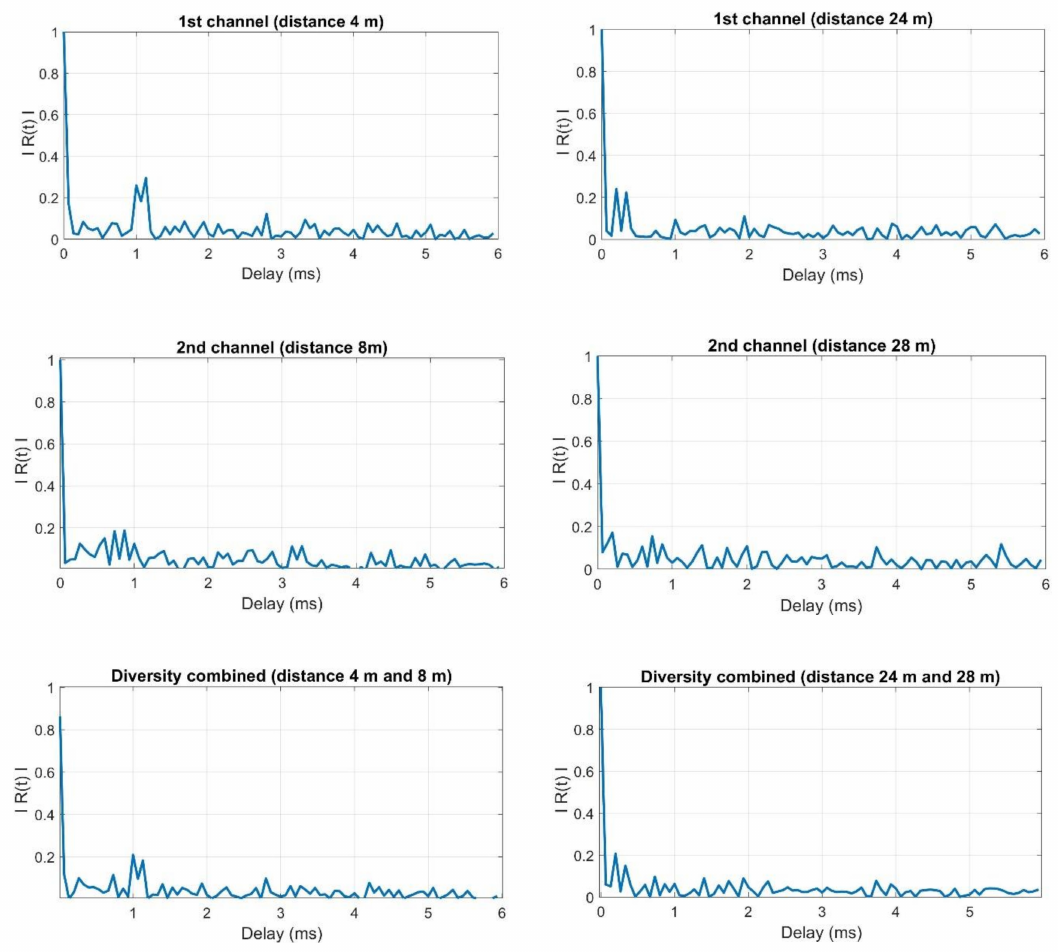
Figure 11. Example of the estimates of the impulse response modules obtained during the tests in real